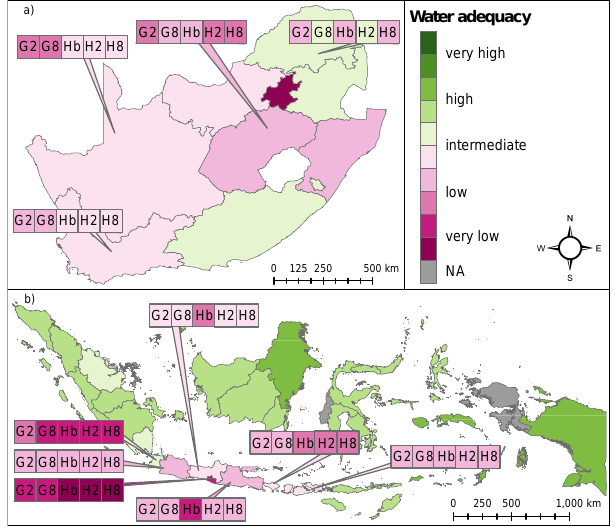
Figure 4. The maps show the integrated measure of water ade- quacy under current conditions (GDFLbase) for (a) South Africa and (b) Indonesia. Coloured boxes show changes in water ade- quacy where these occur, differentiating the models and RCPs. G2: GDFL2.6, G8: GDFL8.5, Hb: HADbase, H2: HAD2.6 and H8: HAD8.5.